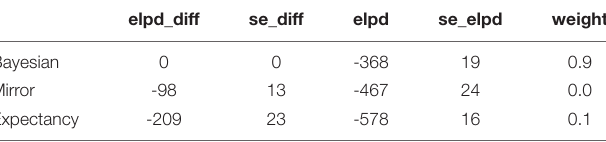
TABLE 18 | Model comparison, Experiment 2.